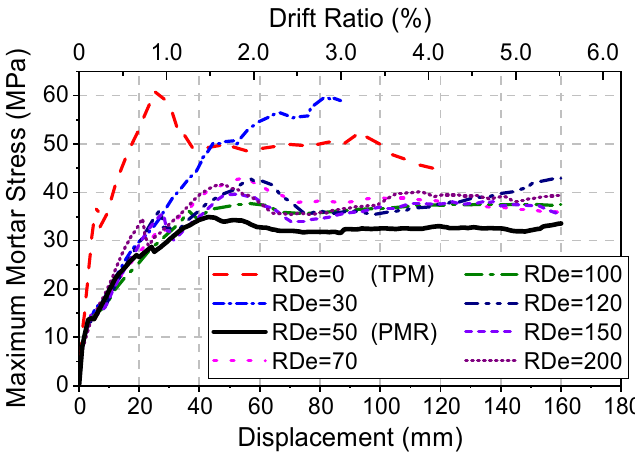
Figure 20. Mortar maximum stress with different recess depths.